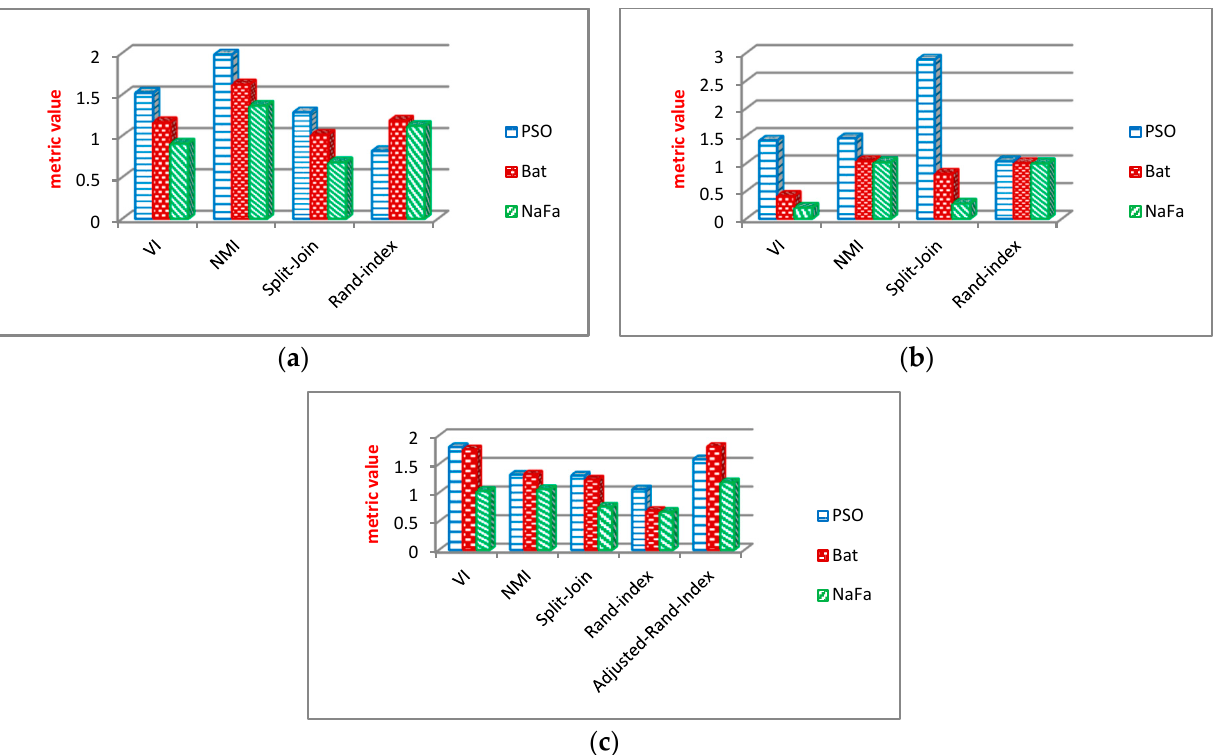
Figure 20. Evaluated values of community structure metrics on ( a ) Dolphins, ( b ) netscience, and ( c ) power grid.